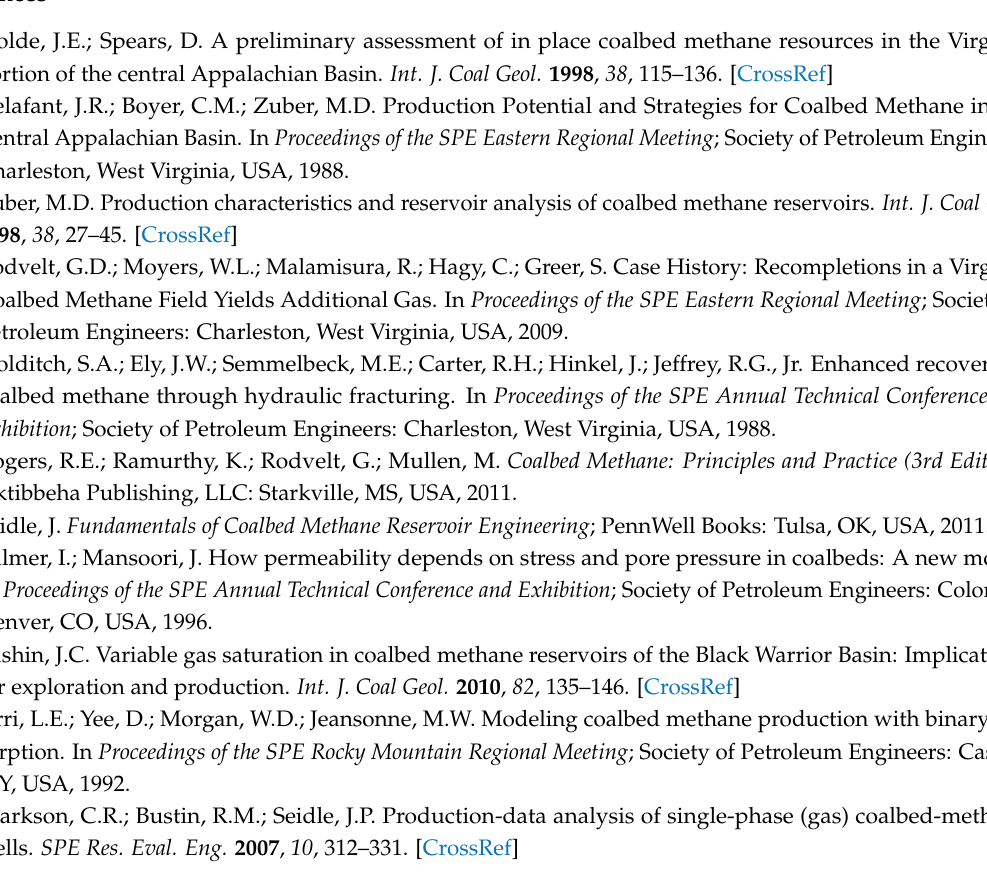
Figure S1: Schematic (a) and real test (b) of Echometer liquid level survey; Figure S2: Acoustic test with reflection surface for depth; Figure S3: Collar counting for depth; Figure S4 Gas composition sampling and analysis facilities; Figure S5: ASTM Method D1945-96 Natural Gas Analysis; Figure S6 Sample NGC Chromatographic